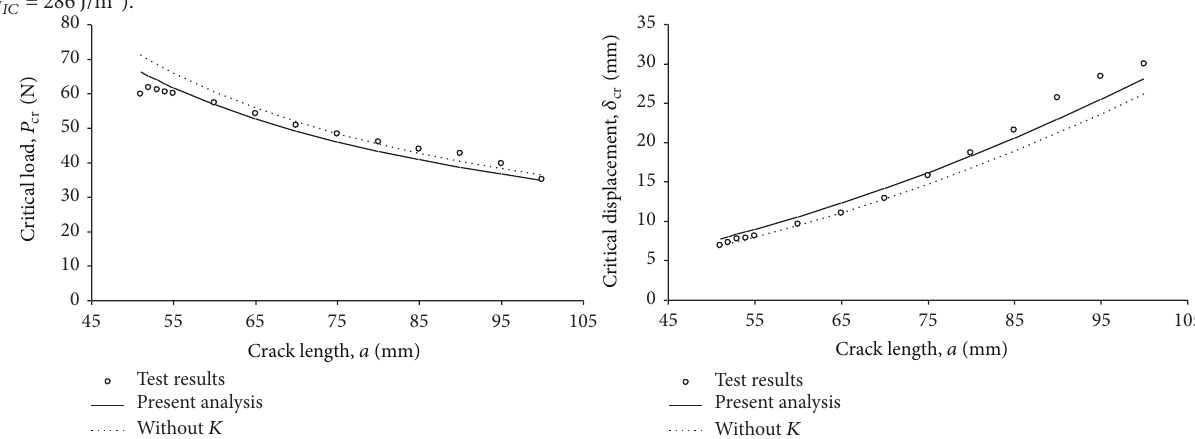
Figure 8: Comparison of experimental [20] and fracture analysis results of the critical load (𝑃 with the crack length of unidirectional DCB specimens made of glass/epoxy composites ( 𝐵 = 25mm, 2 ℎ = 3 mm, 𝐸 = 36 GPa, 𝐾 = 8 Nm, and 2 ). 𝐺 𝐼𝐶 = 286 J/m